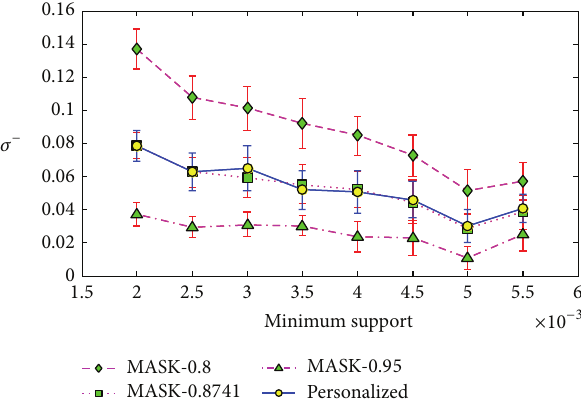
Figure 7: Support error 𝜌 versus minimum support on BMS- WebView-1x10.